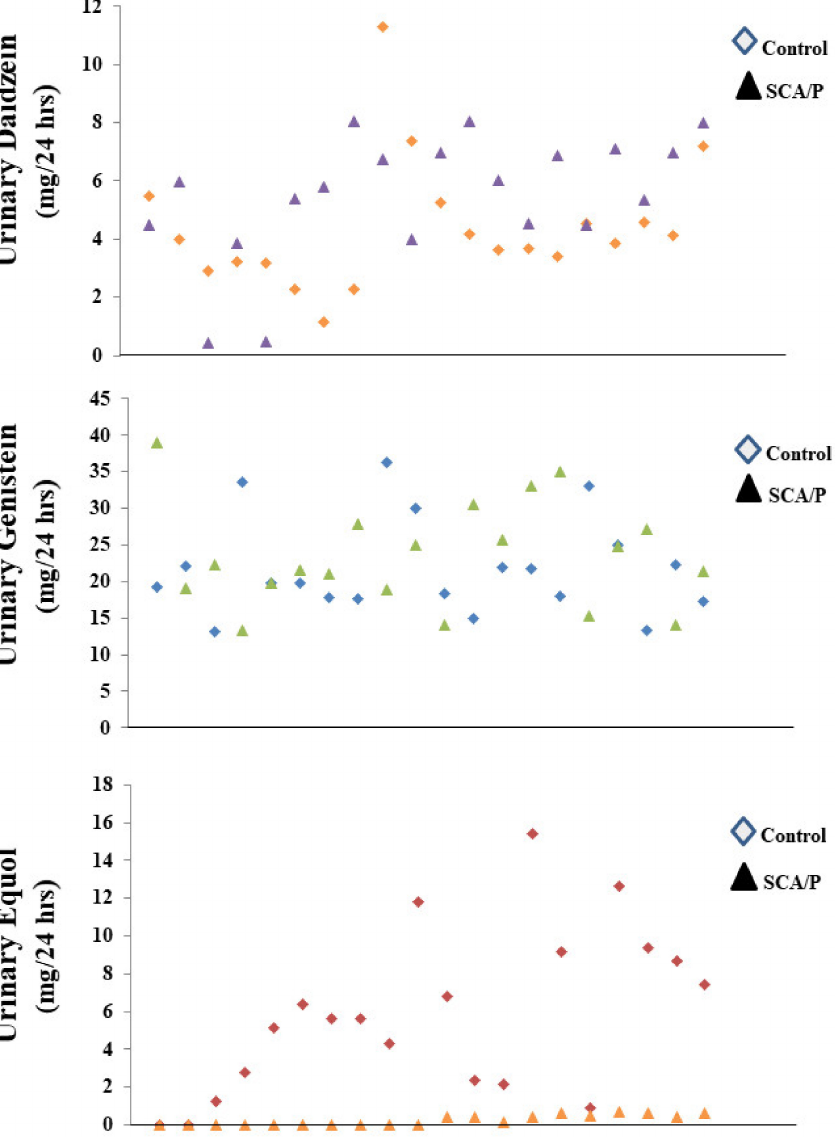
Figure 3. Daidzein, genistein and equol levels, detected by HPLC, in urine samples of controls and SCA / P